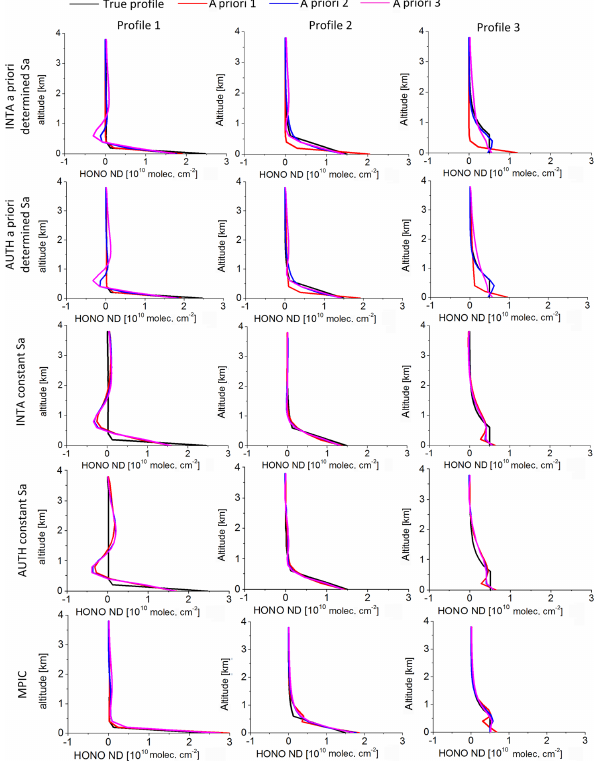
Figure 10. Median and standard deviations of the differences of the HONO VMR profiles retrieved from the simulated HONO delta SCDs with added artificial noise compared to those without noise by the different participants using a different inversion algorithm with “constant Sa” and “a priori determined Sa” (see text). The root mean square of the noise is 3 × 10 14 molec.cm − 2 . The different colours indicate the results for the three different assumed HONO